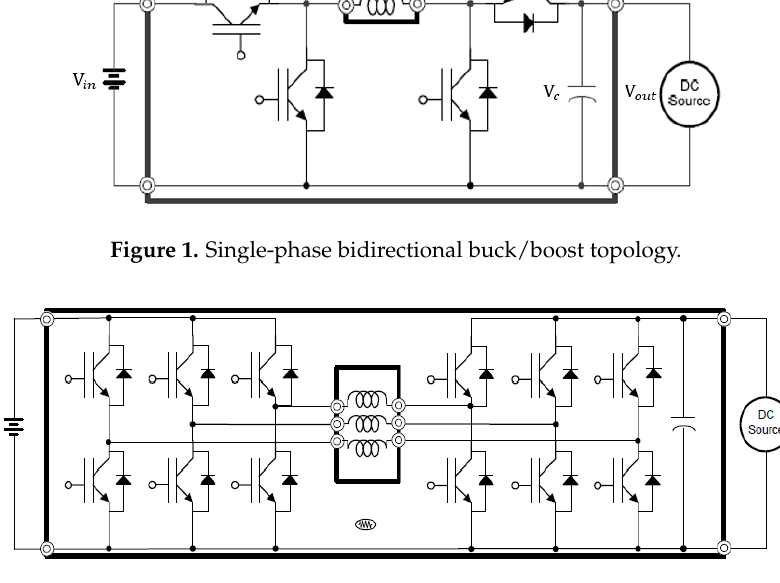
Figure 2. Three-phase bidirectional buck/boost topology.